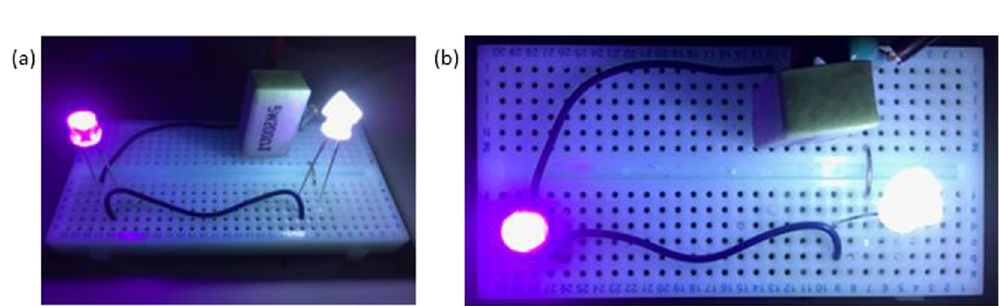
Figure 6. WLE aerogel. ( a ) Emission spectrum of mixture incorporated in to aerogel for WLE. Inset (i) Colour spectrum of the modified aerogel and (ii) photograph of the modified aerogel under UV illumination (390 nm). ( b ) CIE plot for colour coordinate of white light emitting aerogel (0.27,0.33).